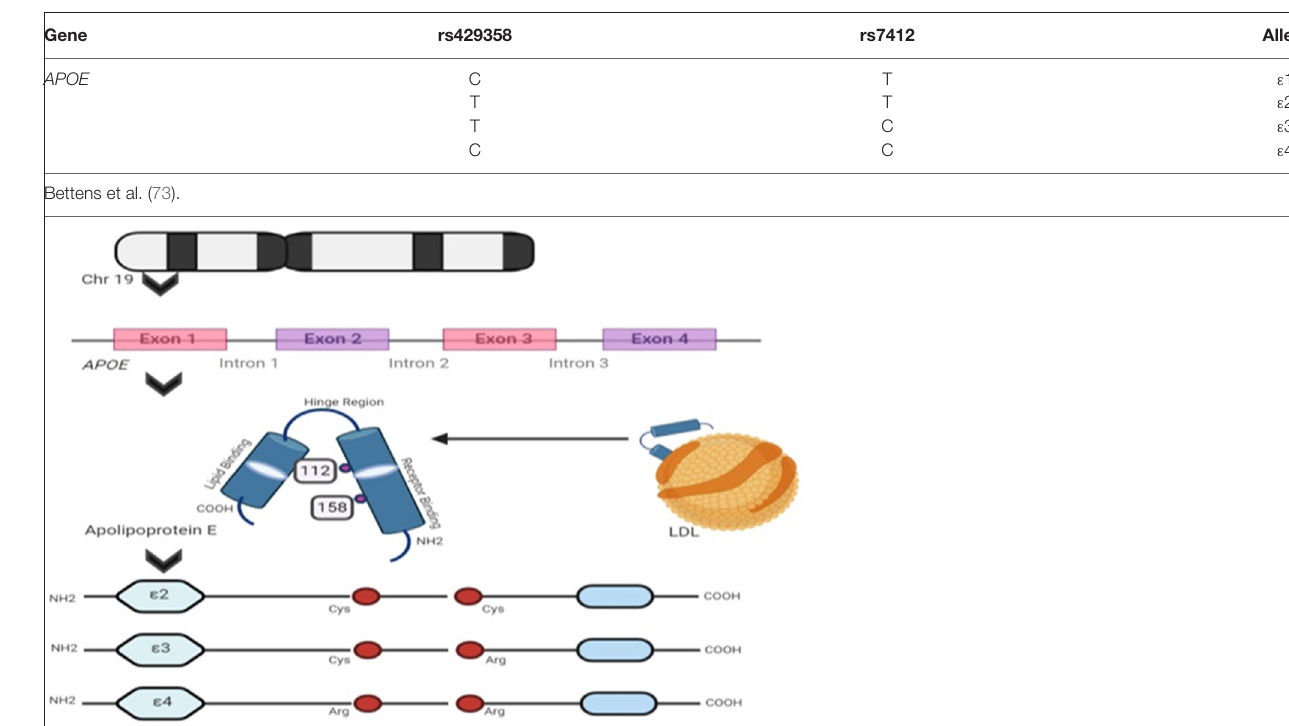
Table 4 . The clinical characteristics and biochemical associations witnessed for various APOE polymorphisms are depicted in Figure 4